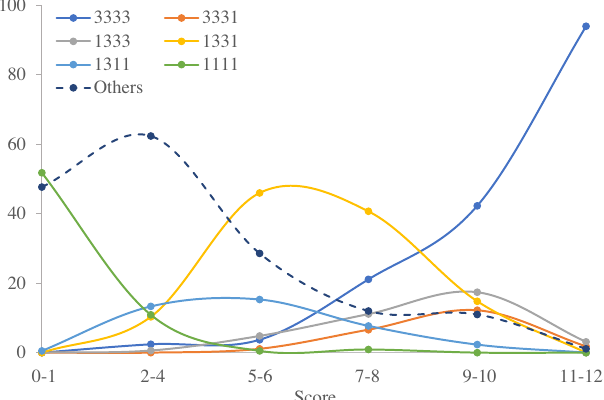
FIG. 5. The pattern response curve of the percentage distribu- tions of the 6 popular four-question patterns for students at different overall performance levels. The single dashed line represents the combined outcome of other